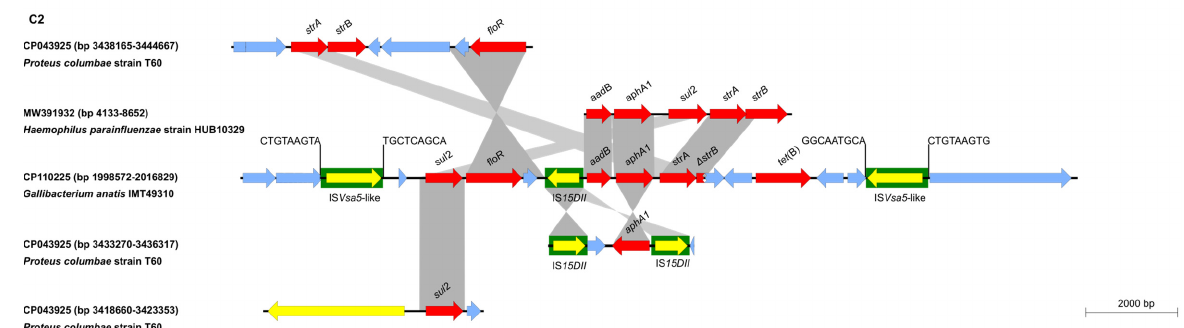
Figure 1. Organization of the resistance gene regions of G. anatis IMT49310. Open reading frames are shown as blue arrows, resistance genes are marked in red, transposase genes in yellow, and integrase genes in orange. The arrowheads indicate the direction of transcription. IS or integrative and conjugative elements and transposons are depicted as green boxes, and grey shading indicates similarities between sequences. ( A1 , A2 ) Schematic representation and alignment of resistance gene region I of G. anatis IMT49310 (CP110225) with sequences CP002667 ( G. anatis UMN179), CP000645 ( Aeromonas salmonicida ssp. salmonicida A449 plasmid 4), CP026932 ( Escherichia coli strain CFS3273 chromosome) and CP026933 ( E. coli strain CFS3273 plasmid pCFS3273-1) from GenBank. ( B ) Schematic representation and alignment of resistance gene region II of G. anatis IMT49310 (CP110225) with sequences CP002667 ( G. anatis UMN179), CP034465 ( Jeotgalibaca ciconiae strain H21T32 chromosome) and FR671418 ( Streptococcus pneumoniae strain 9409 Tn 916 -type integrative and conjugative element) from Genbank. ( C1 , C2 ) Schematic representation and alignment of resistance gene region III of G. anatis IMT49310 (CP110225) with sequences CP002667 ( G. anatis UMN179), CP029322 ( Pasteurella multocida strain 14424), CP043925 ( Proteus columbae strain T60 chromosome), and MW391932 ( Haemophilus parainfluenzae strain HUB10329) from GenBank.